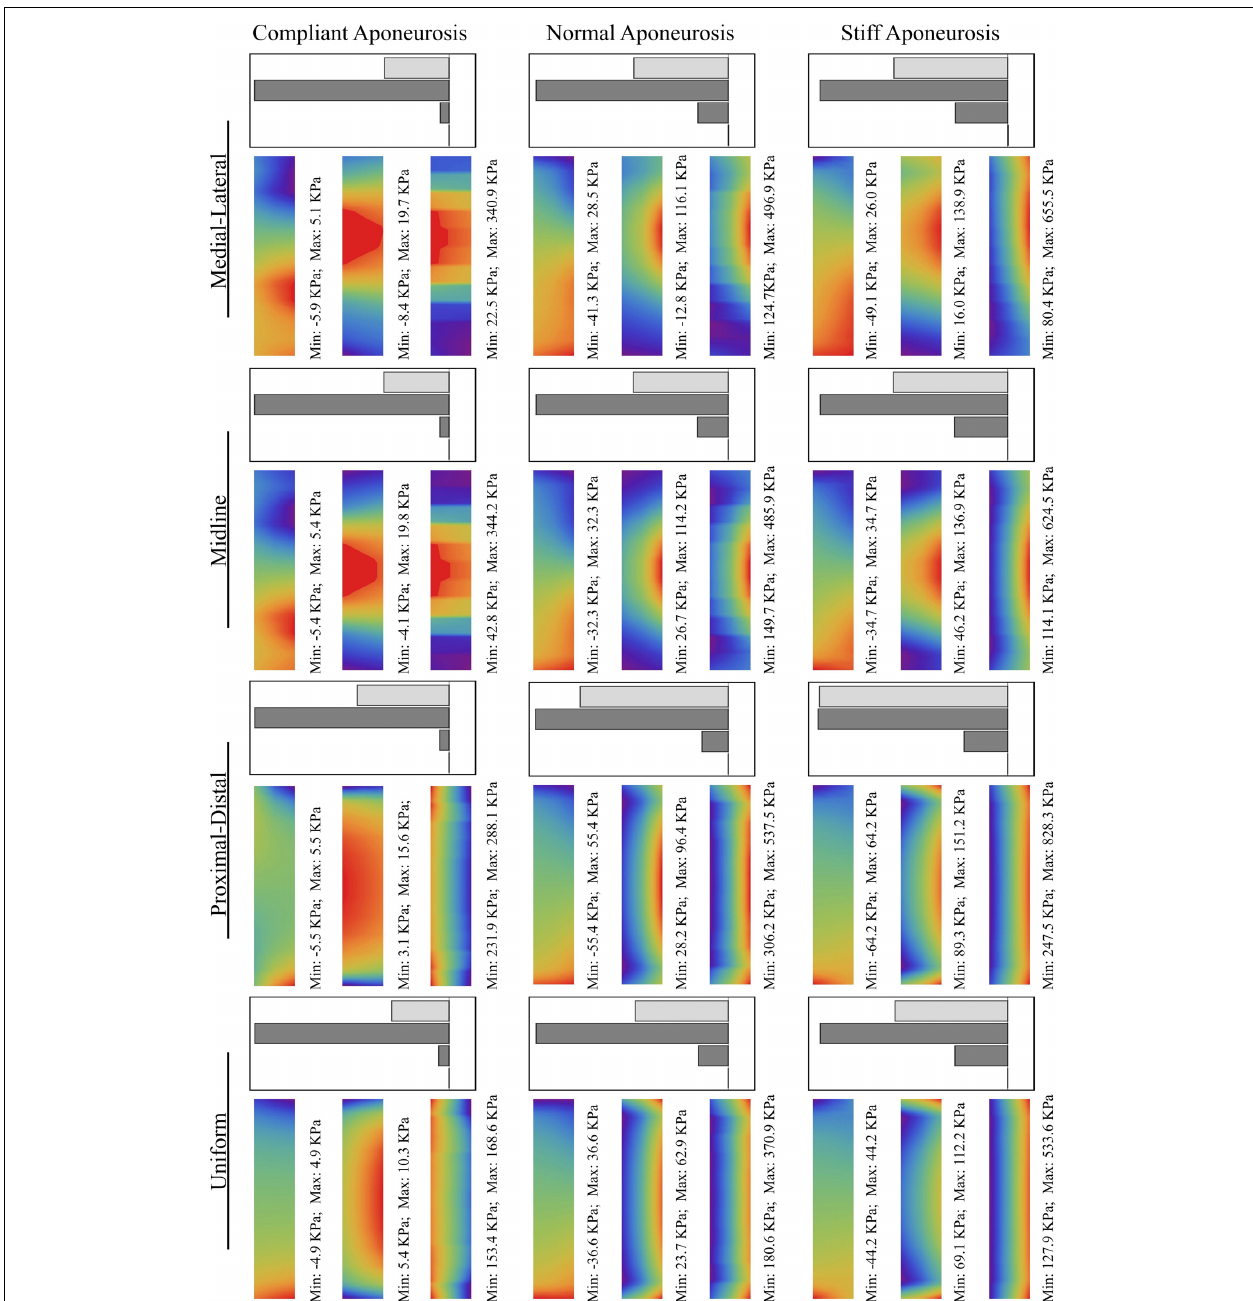
FIGURE 5 | Stress contours and force magnitudes and directions for the 12 test conditions. The scales are shown in Figures 4B,C .